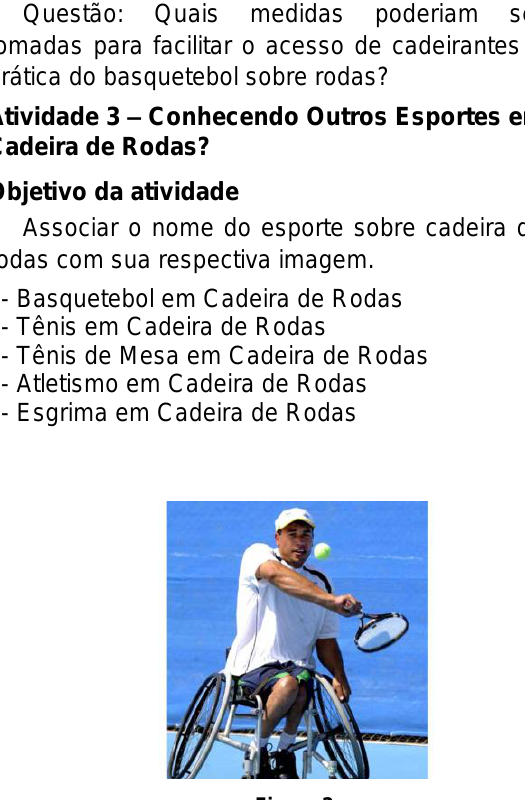
Figura 1. http://static.hsw.com.br/gif/parapan- americano-basquete.jpg